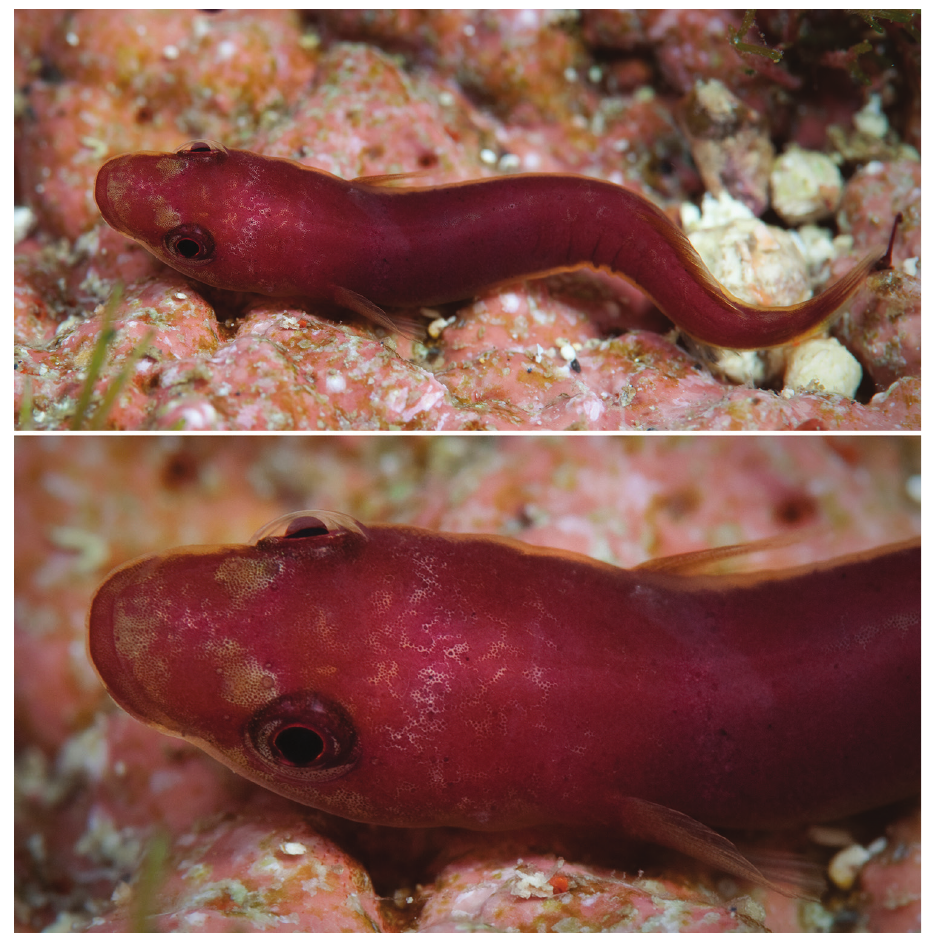
Figure 2. Flexor incus , Te konui Point, Raoul Island, Kermadec Islands, 28 meters depth, photographed by R. Robinson ( www.depth.co.nz ) during the 2011 Kermadec Islands Biodiscovery Expedition, a pro- ject led by the Auckland Museum. Specimen not